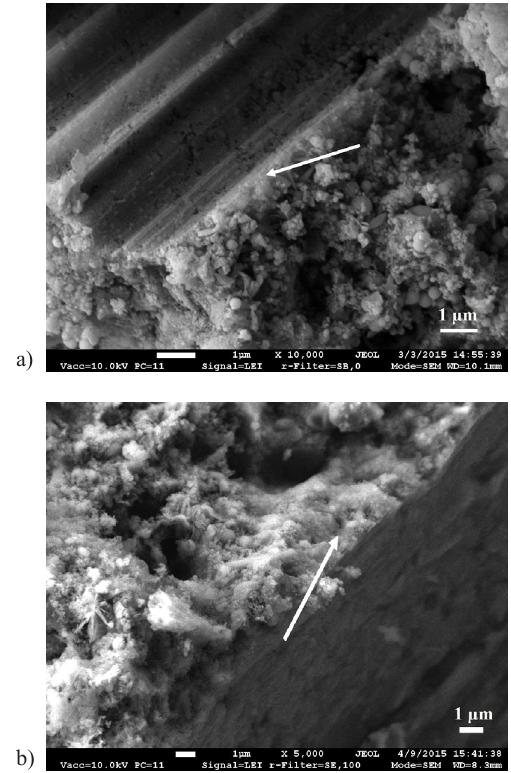
Fig. 4. Densified castable sample